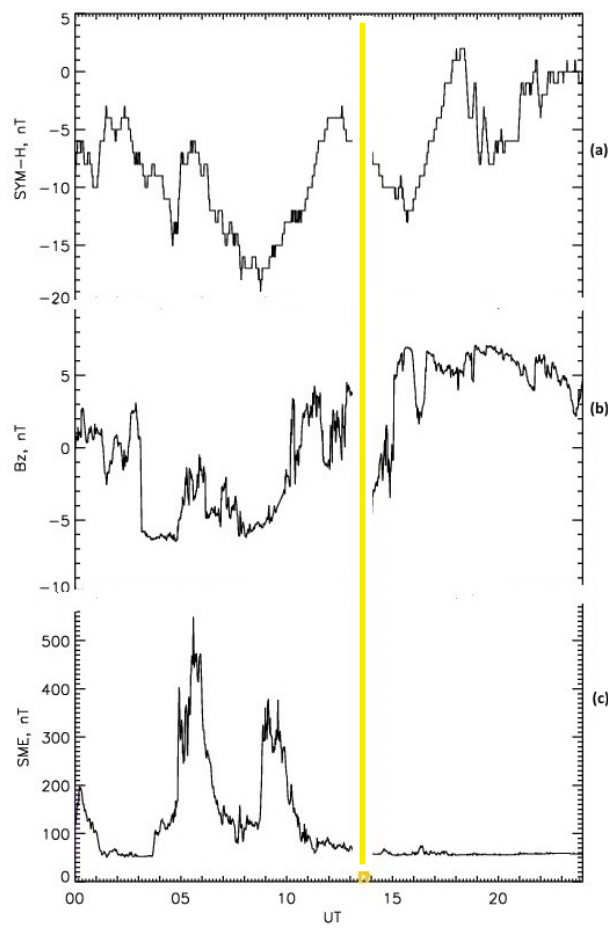
Figure 4. Geomagnetic disturbances during 14 December 2009. (a) SYM-H index variability. (b) IMF Bz variability. (c) SME index variability. The yellow line marks the time of balloon